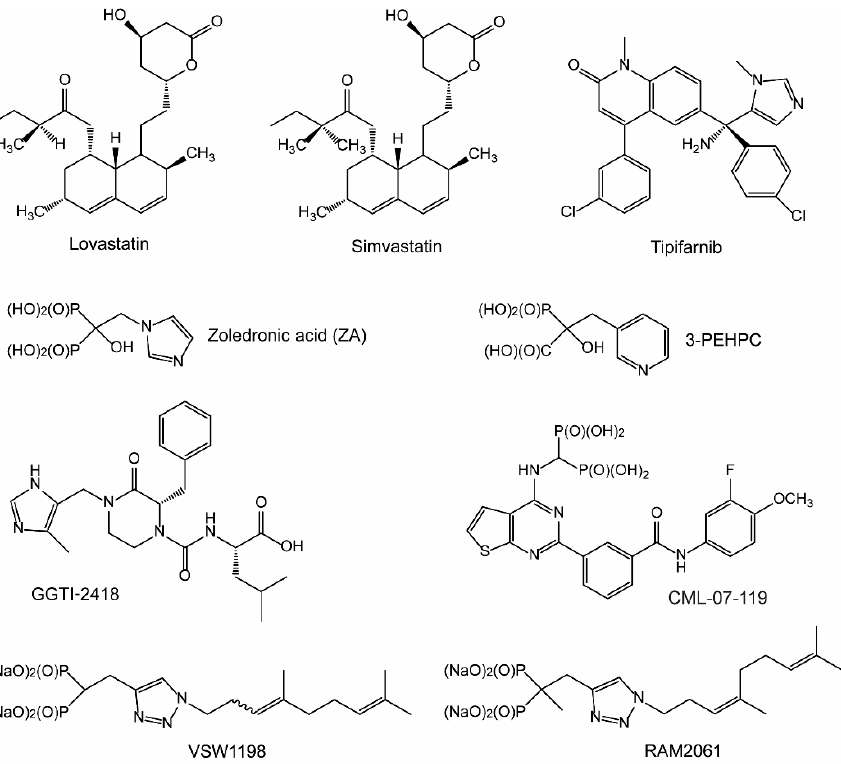
Figure 2. Isoprenoid biosynthetic pathway (IBP) and prenyltransferase inhibitors. The chemical structures of select inhibitors are shown above.